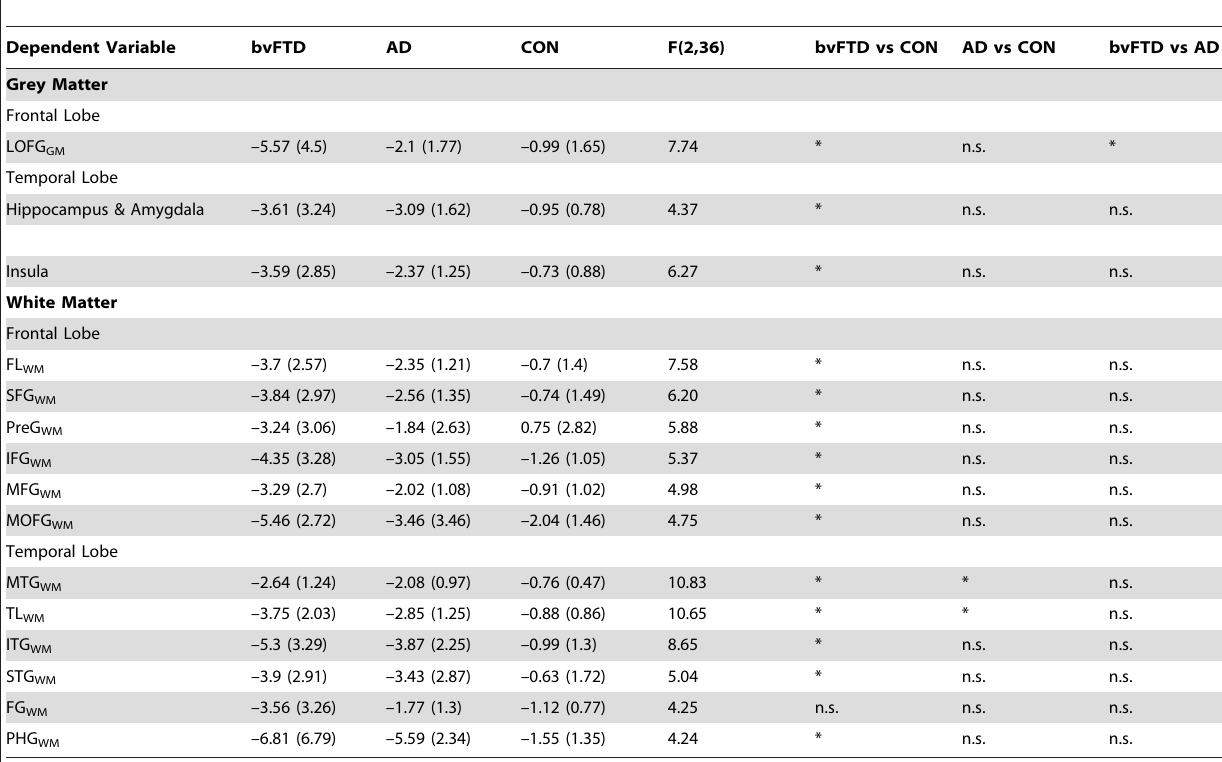
Table 4. Anatomical structures that showed significant group differences of annualised volume change (FDR-corrected p0.05). Per group mean and S.D. (in %), univariate between-subjects effects, and pairwise post-hoc Bonferroni test